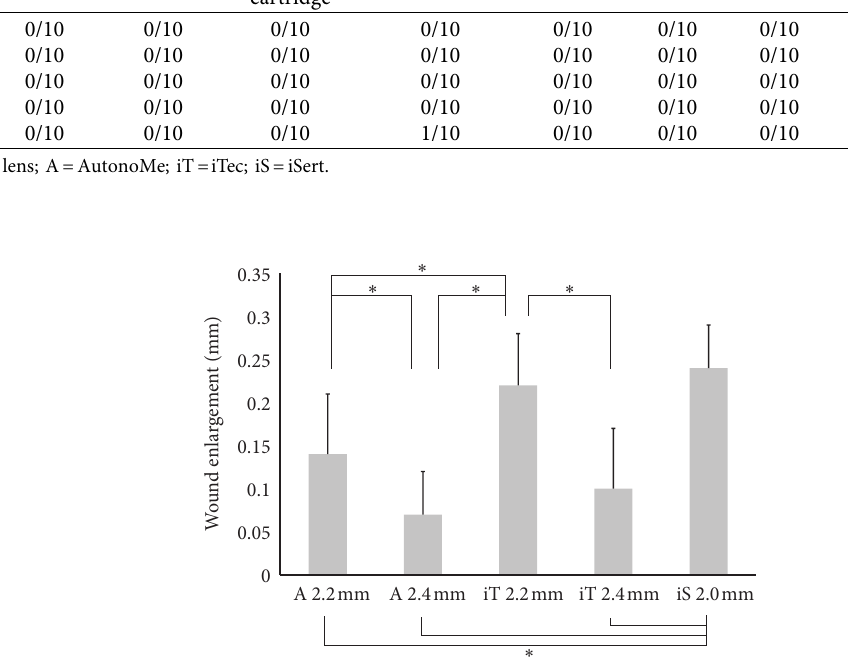
Figure 1: Mean enlargement with corneal incisions ( ± SD) ( ∗ P < 0 . 05, one-way analysis of variance) (A � AutonoMe; iT � iTec; iS � iSert). Table 4: Mean enlargement and final size of corneal